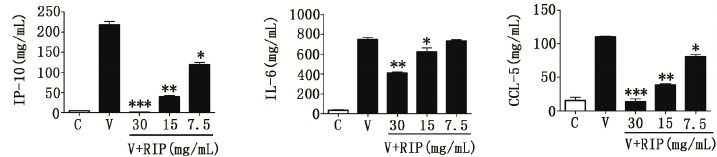
Figure 2. Radix isatidis polysaccharides can inhibit cytokine expression induced by H9N2 avian influenza A virus in 16HBE cells. After being mock-infected or infected with H9N2 (MOI = 1), 16HBE cells were treated with R. isatidis polysaccharides or 0.5% DMSO. The protein levels of IP-10, IL-6, and CCL-5 were tested by ELISA. RIP: R. isatidis polysaccharides. Statistical significance was evaluated using the Student’s t -test, relative to the mock-infected cells ( * p < 0.05, ** p < 0.01, *** p < 0.001).